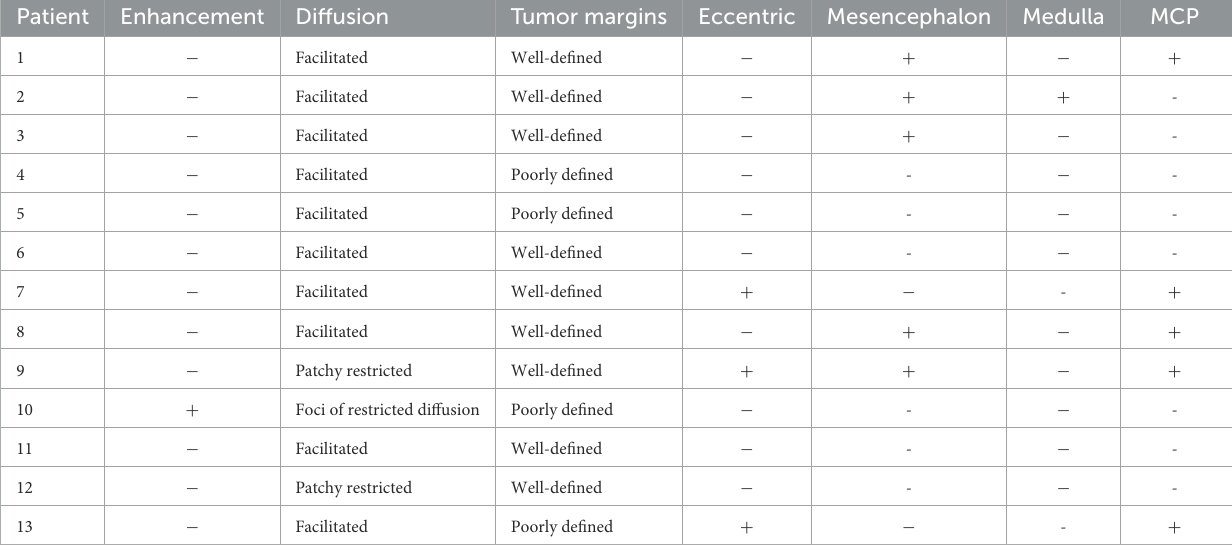
TABLE 2 Baseline tumor characteristics.